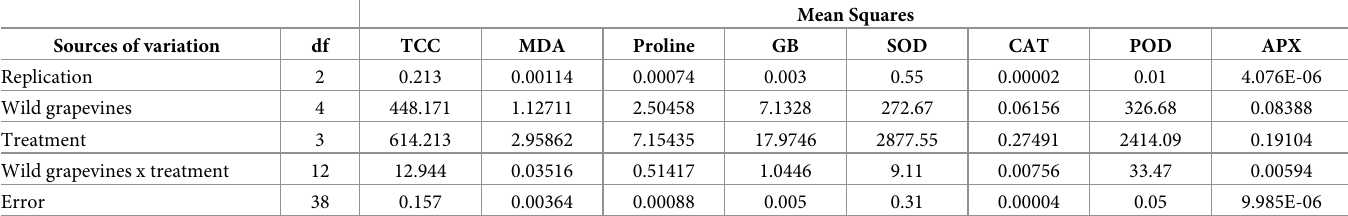
Table 1. Analysis of variance for enzymatic and non-enzymatic biochemical traits of commercial scion variety Kings Ruby grafted on different wild grapevines under drought stress condition.